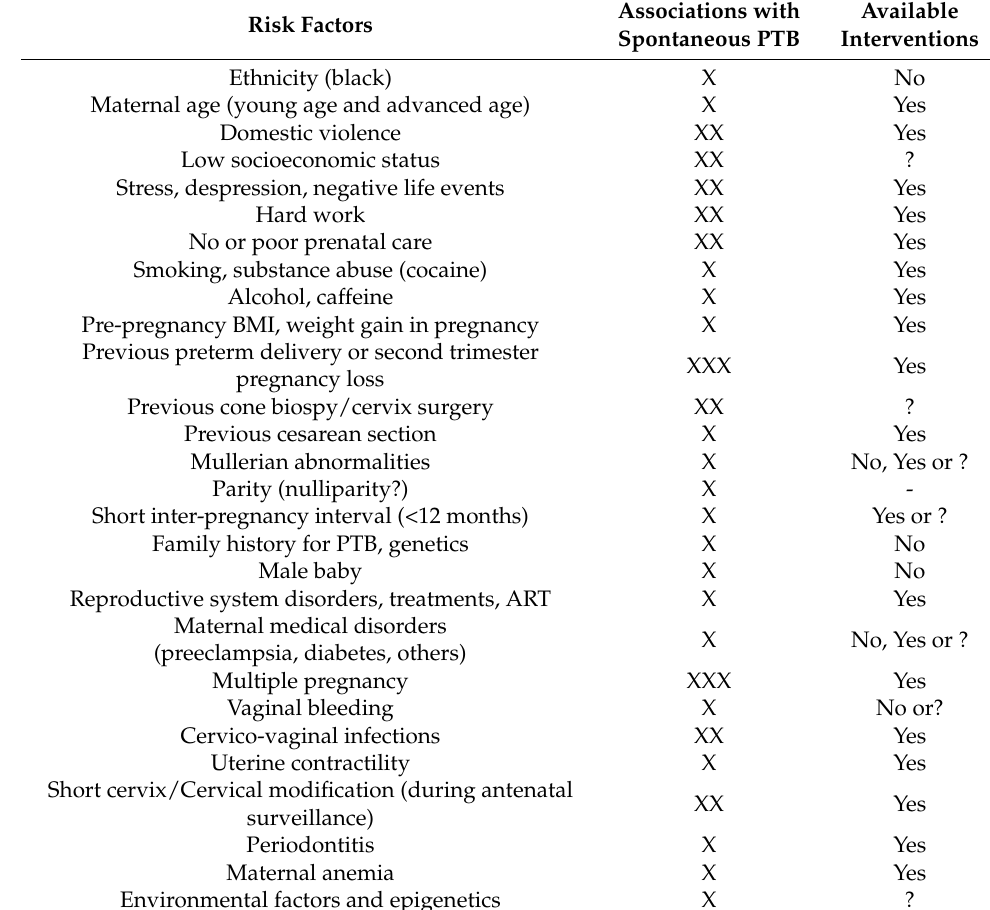
Table 1. Risk factors, level of association with spontaneous PTB, available preventive-therapeutic interventions